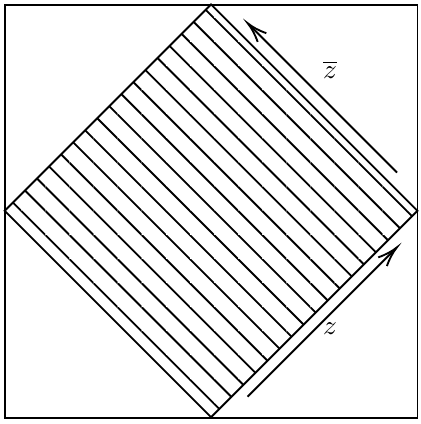
Figure 2 . The celestial torus. The top/botttom and left/right edges of the square are identified. Null momenta with z, ¯ z, ω > 0 , ε = 1 cover a single Poincaré patch (shaded). Momenta with ε = − 1 cover the unshaded Poincaré